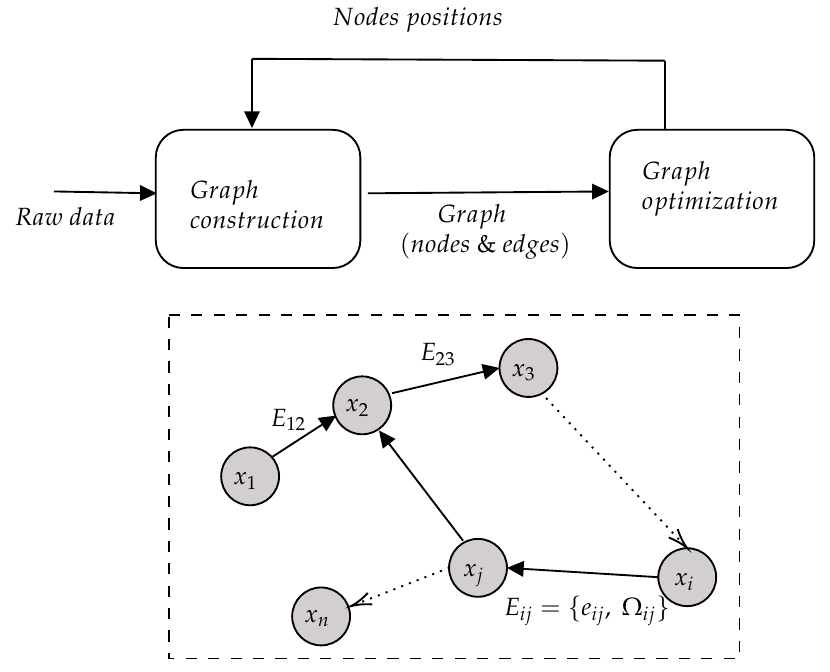
Figure 3. Representation of a pose-graph SLAM process. Every node x i in the graph corresponds to a robot pose. Nearby poses are connected by edges E ij = { e ij , Ω ij } that represent the spatial constraints between the robot poses i and j (coming from measurements). Note that edges e ij model the proprioceptive information constraint and Ω ij the exteroceptive